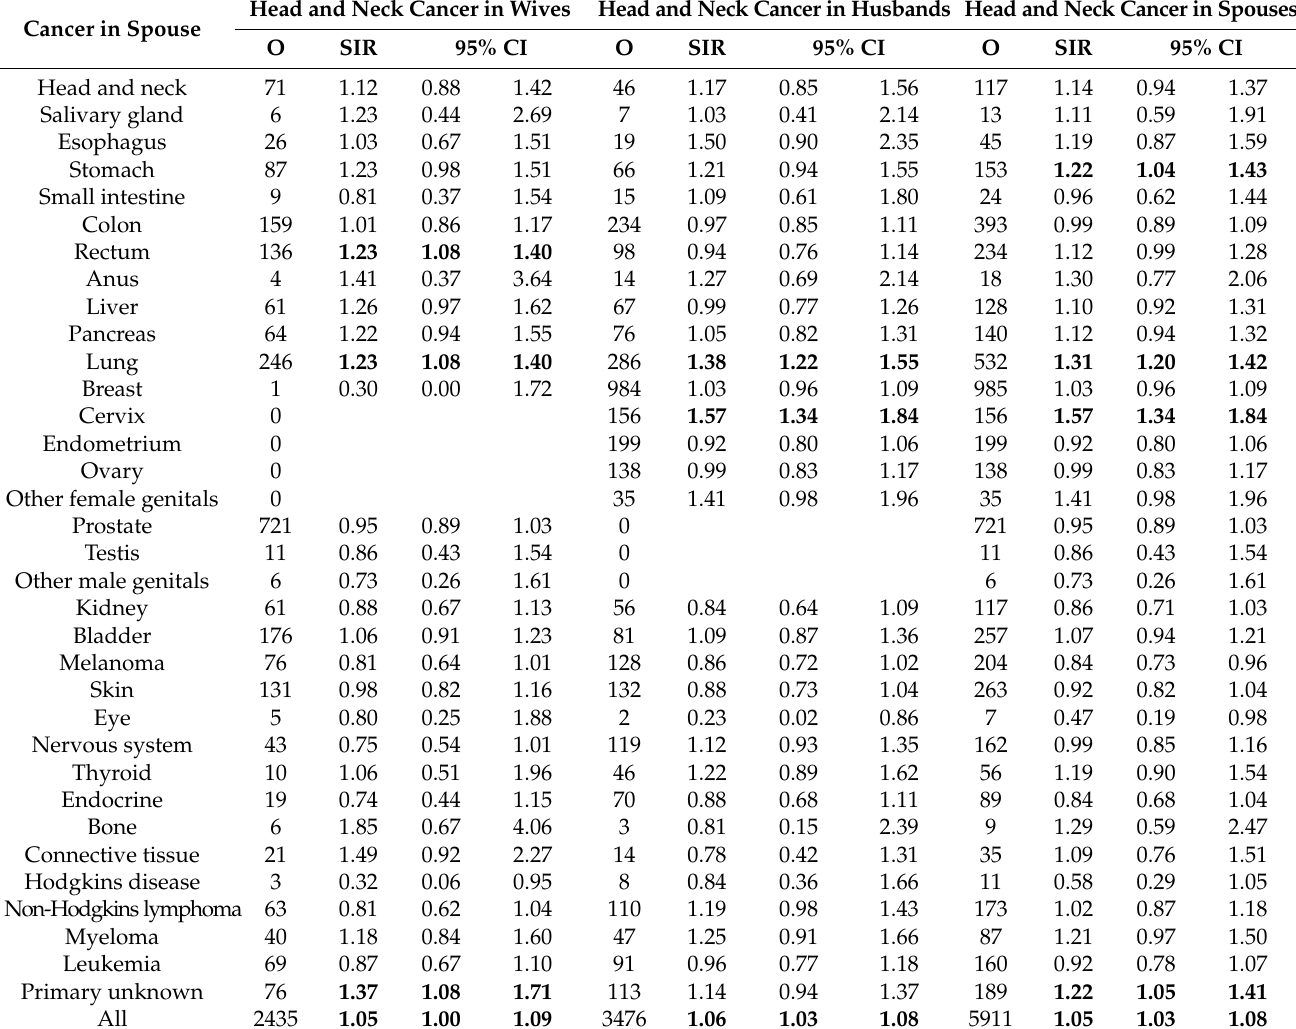
Table 6. Risk of head and neck cancers in a spouse when the other spouse was diagnosed with any cancer. Cancer in